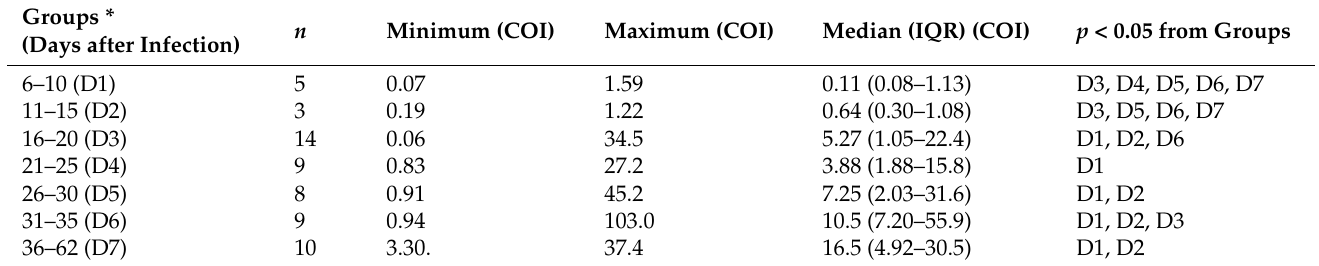
Table 2. Quantitative values of anti-N COI of participant groups divided based on the period from SARS-CoV-2 infection to blood collection.